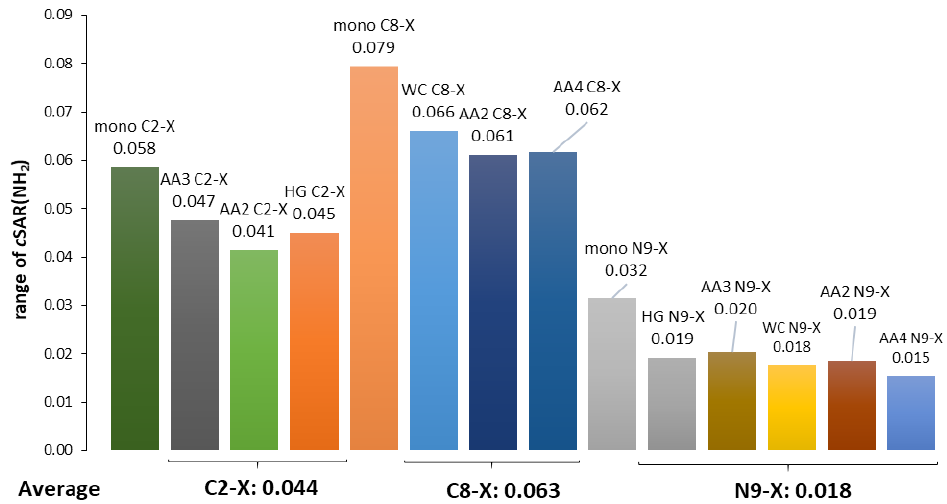
Figure 3. Ranges of cSAR(NH 2 ) variability and their averaged values in substituted adenine monomers and dimers (WC, HG, and AA). Table 1. Slopes of the obtained linear dependences c SAR(NH 2 ) vs. c SAR(X) and determination coe ffi cients ( R 2 ) for the substituted WC and HG base pairs, adenine dimers, and substituted monomers (marked in bold , data taken from Ref. [19]) (A-C2-X, A-C8-X, A-N9-X). For asymmetrically substituted AA2 C2-X, C8-X dimer, the cSAR values of underlined monomers are taken.